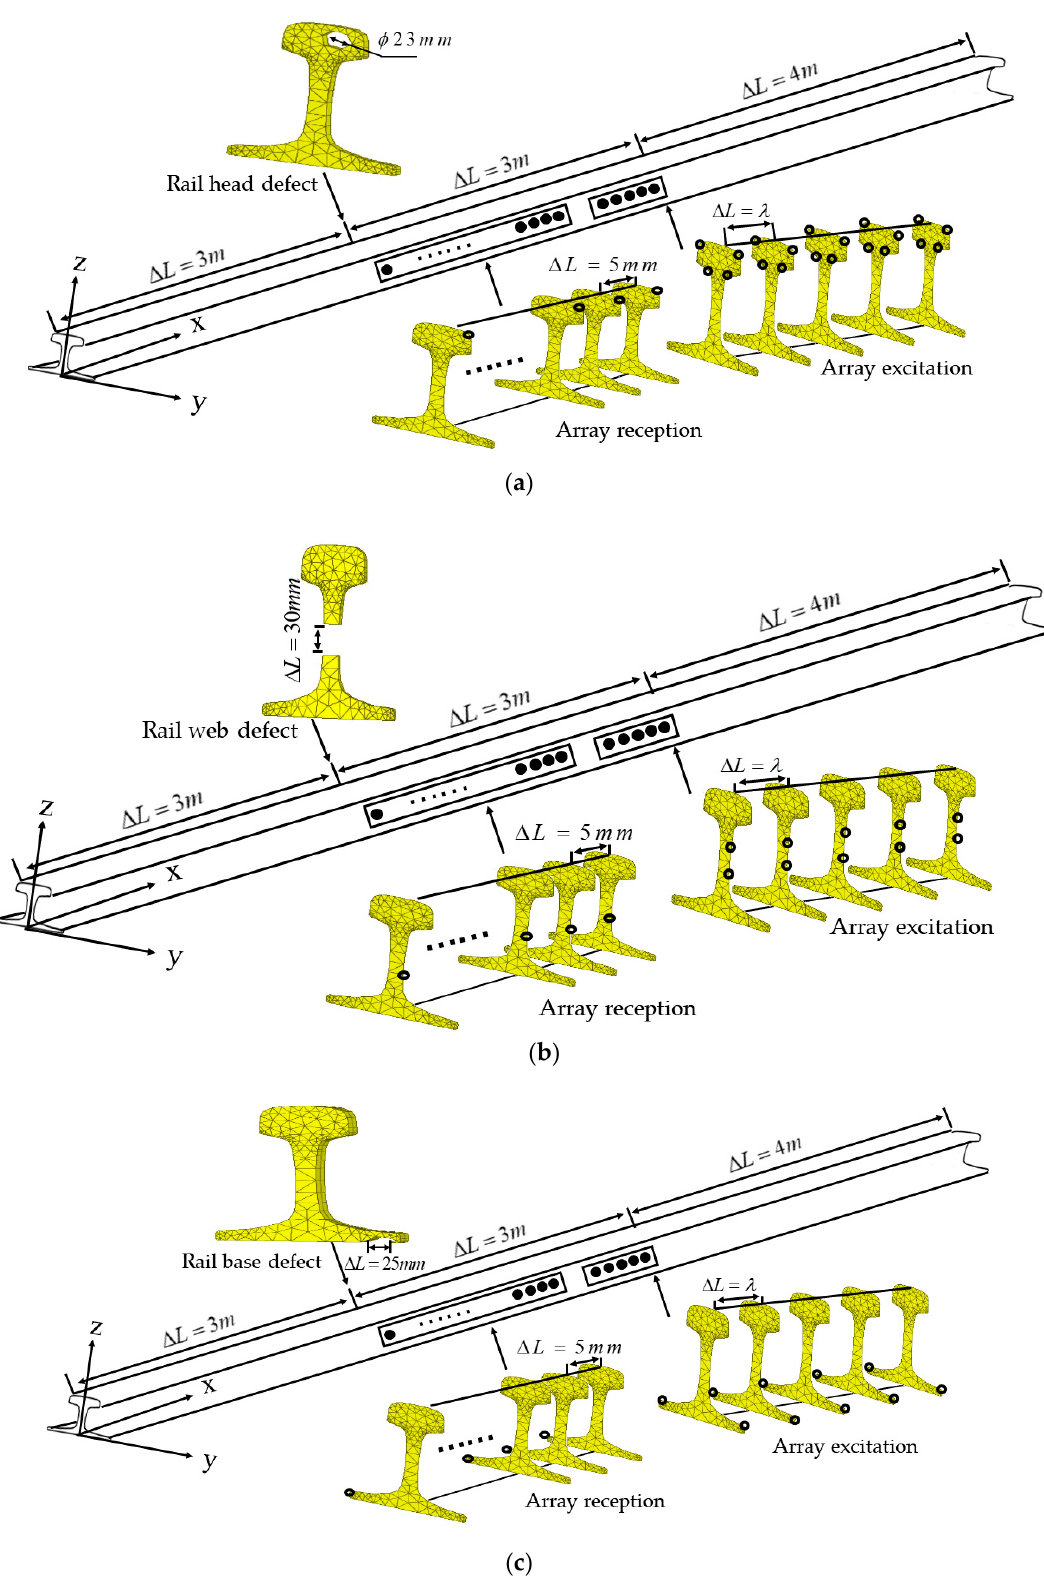
Figure 13. Defect detection simulation diagram. ( a ) diagram of array excitation mode 7 defect detection; ( b ) diagram of array excitation mode 3 defect detection; ( c ) diagram of array excitation mode 1 defect detection.